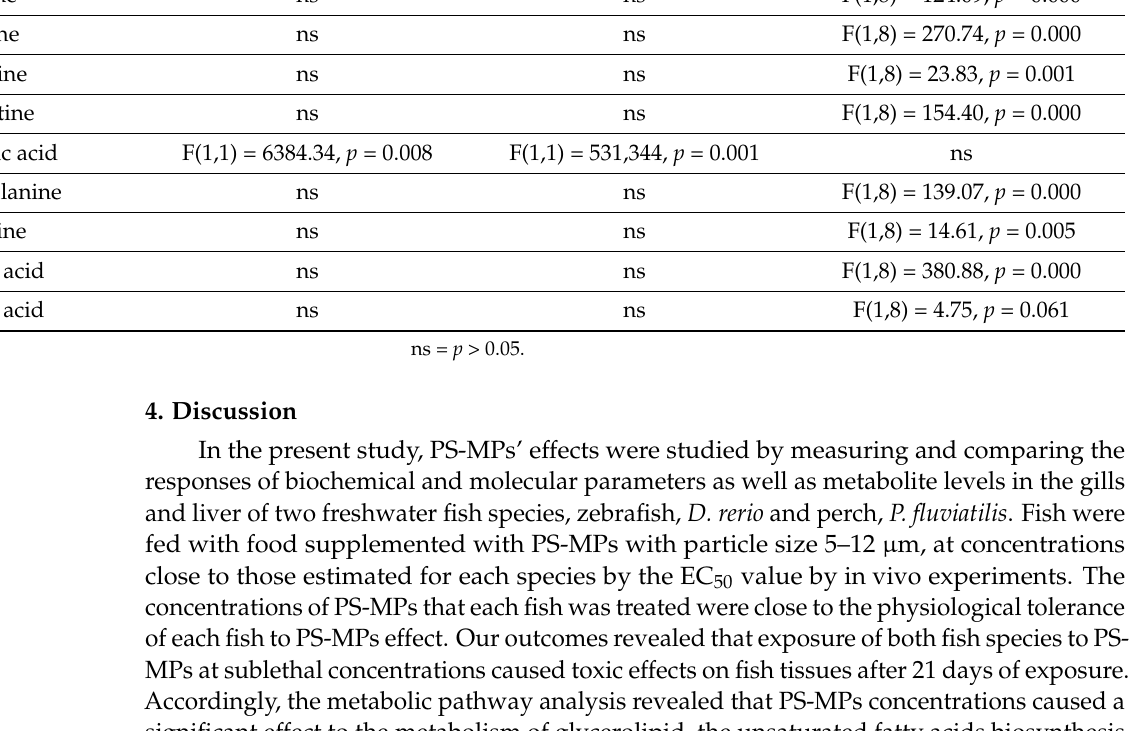
Table 4. Nested Anova of the effects of species, tissue and species-tissue combination on the metabolites studied. Metabolites Species Tissue Species -Tissue Betaine ns